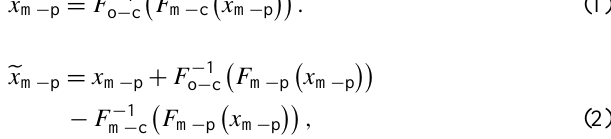
Figure 1. The separate regions within China: Northeast China, North China, Eastern Northwest China, Western Northwest China, Southwest China, Southeast China, and Tibet plateau are marked by NE, N, ENW, WNW, SW, SE, and Tibet